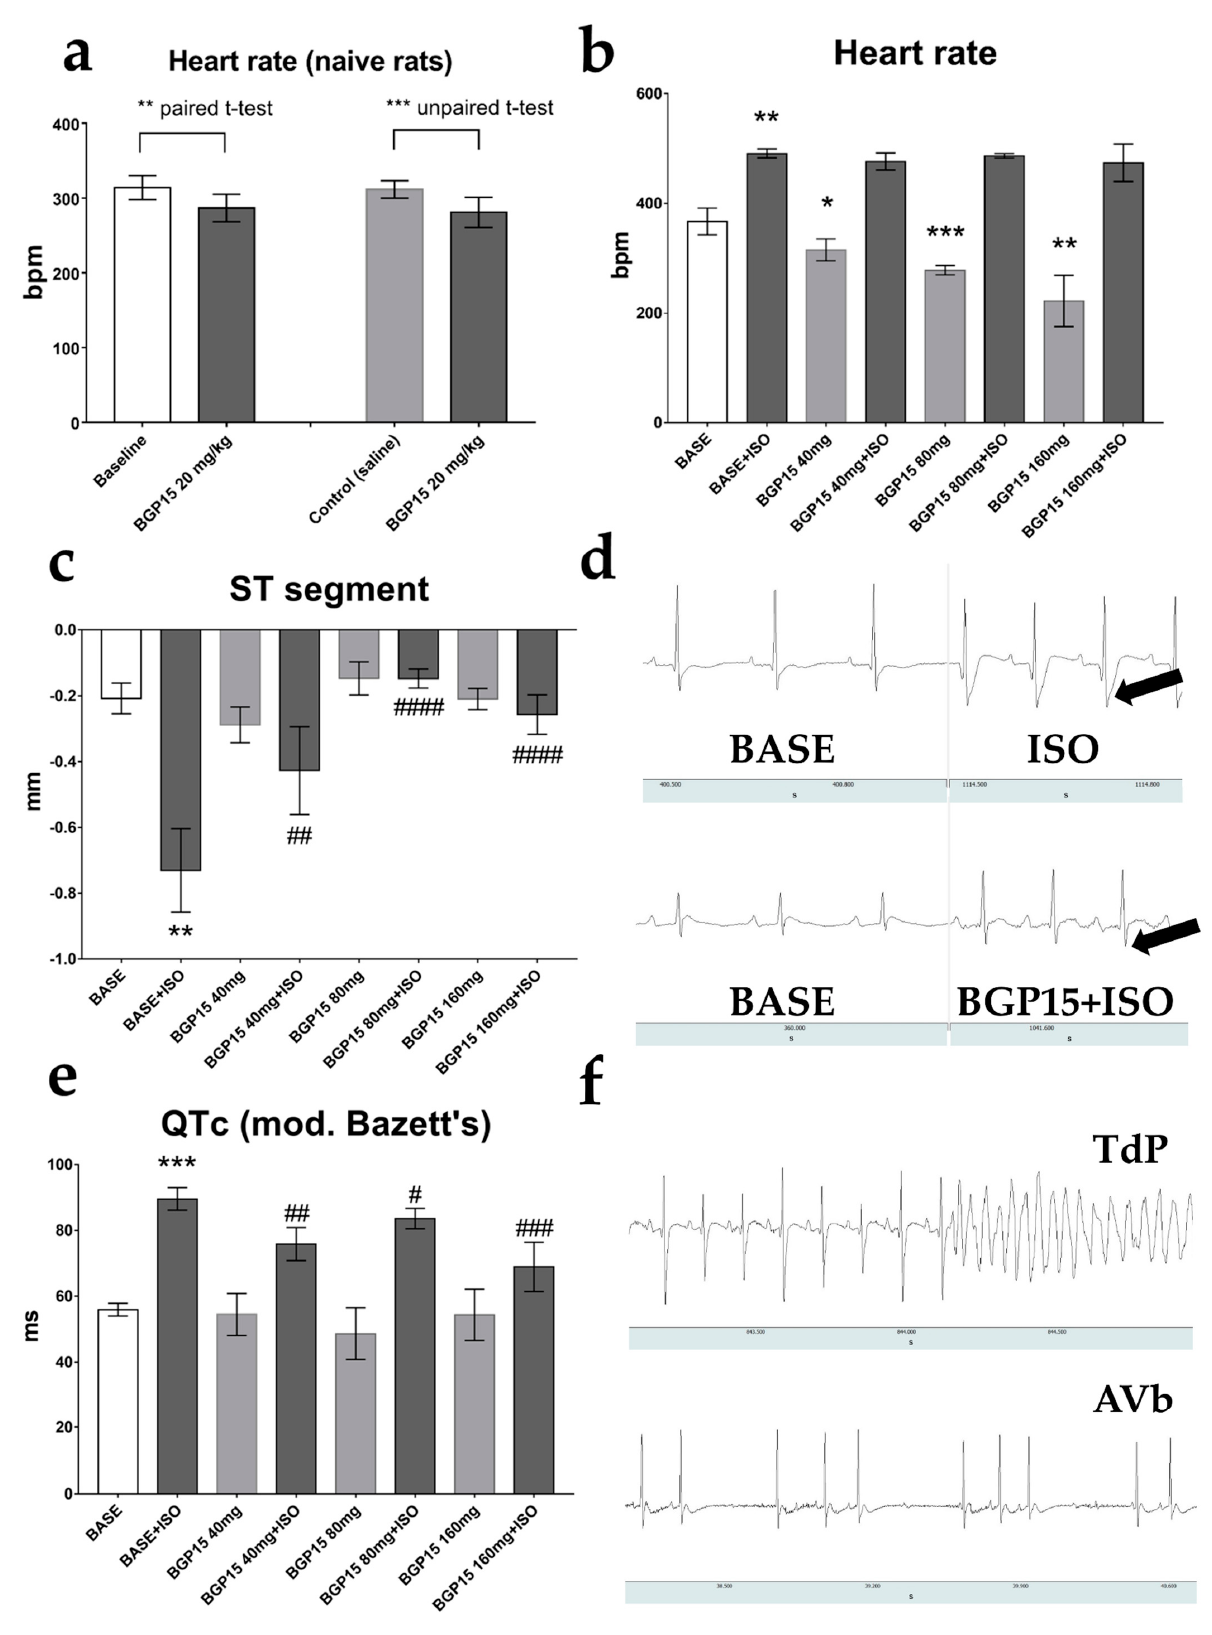
Figure 1. Effects of BGP-15 dose-escalation on ECG parameters of telemetry-implanted rats. ( a ) BGP- 15 (20 mg/kg) decreased mean heart rate. ( b ) BGP-15 treatment (40–160 mg) decreased heart rate